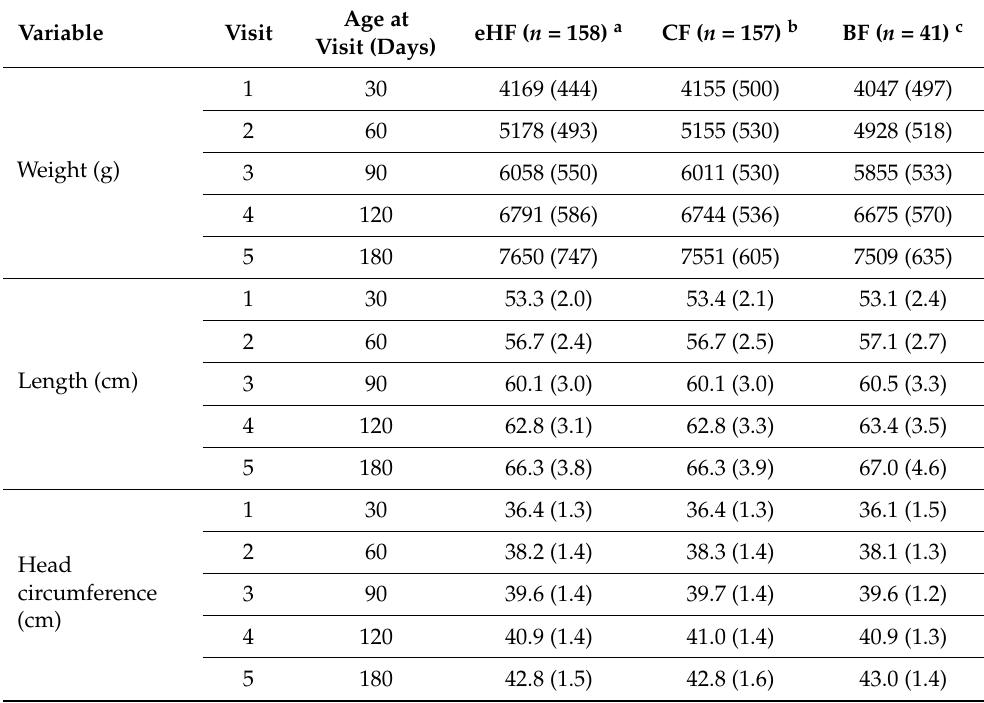
Table 3. Absolute weight, length and head circumference from 30 days of age (V1) to 180 days of age (V5) (FAS), mean